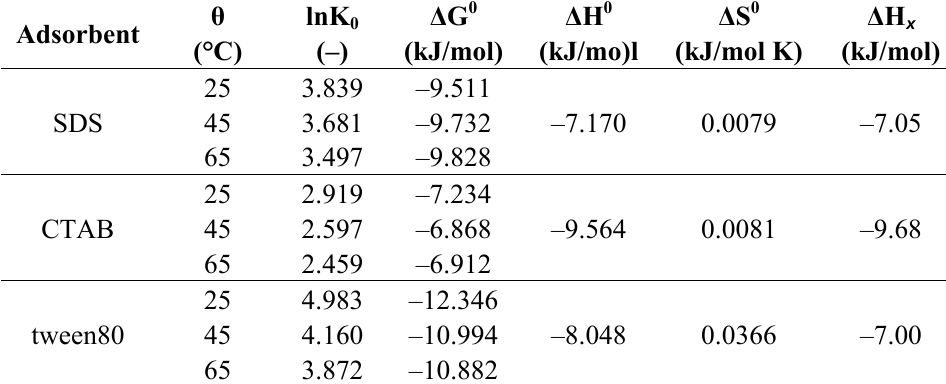
Table 3. Thermodynamic parameters for adsorption of surfactants on